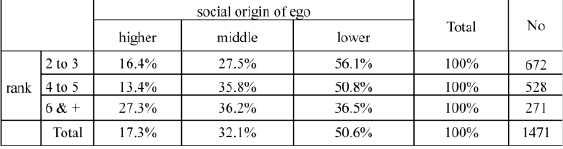
Table 7. Intermediaries' rank by Ego's social